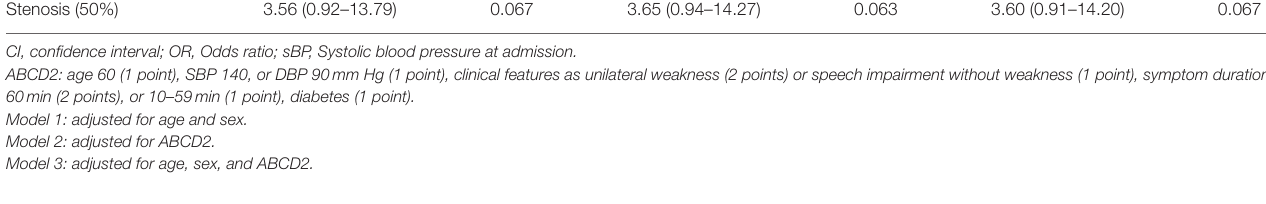
Model 2: adjusted for ABCD2. Model 3: adjusted for age, sex, and ABCD2.